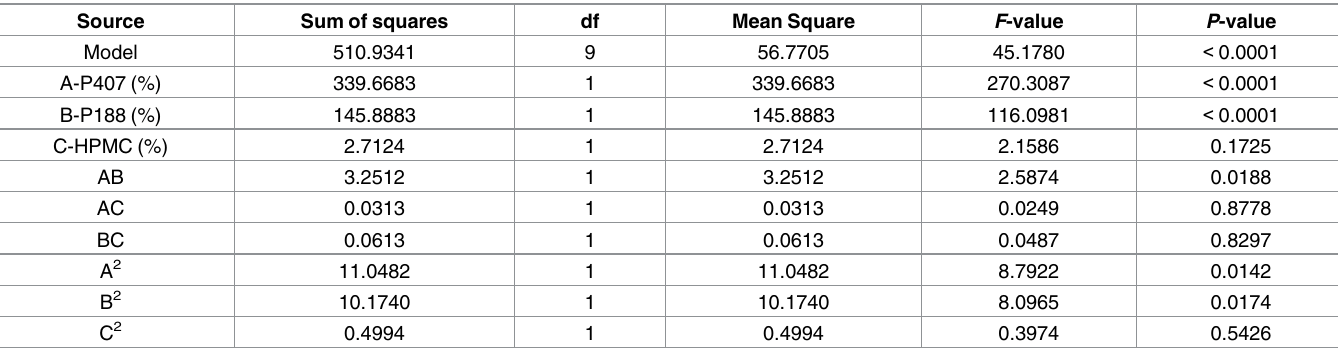
Table 5. ANOVA for response surfacequadratic